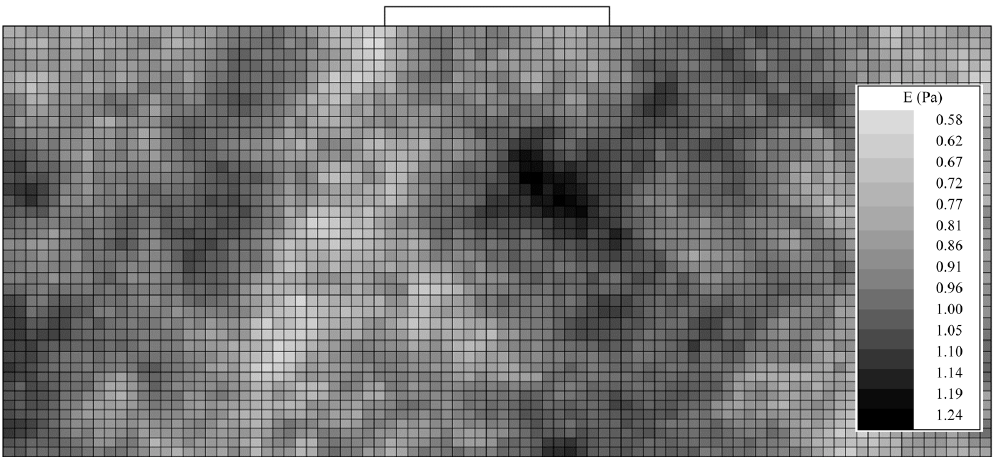
θ / B = 5; see Table 1). Geosciences 2019 , 9 , x FOR PEER REVIEW 13 of 20